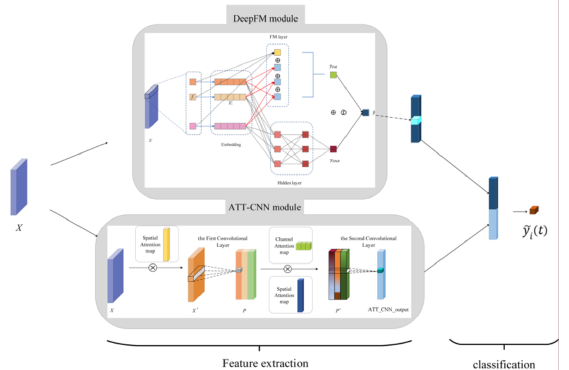
Figure 1. The structure of the FA-CNN model.